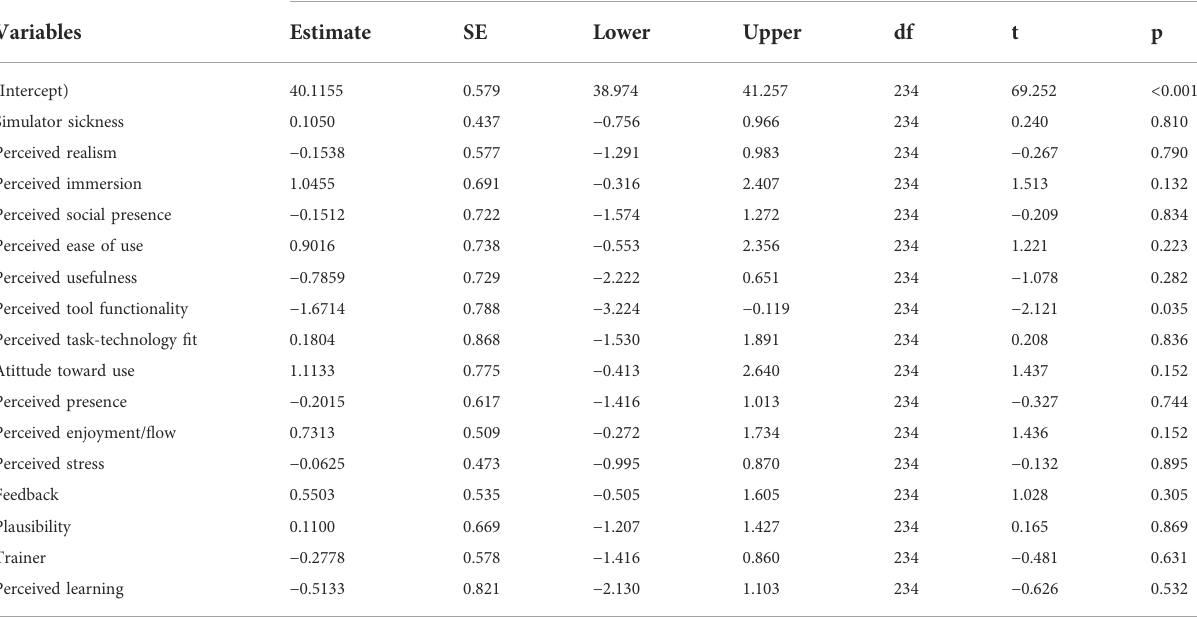
TABLE 6 Estimates of the relationships between age/experience and VR training experiences and